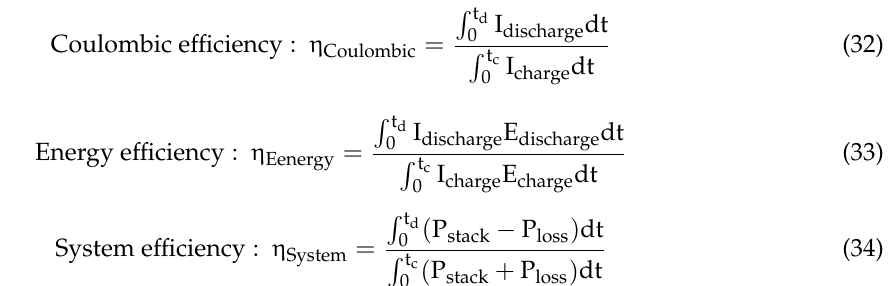
Figure 14. ( a ) System power consumption under different flow control strategies during charging process; ( b ) system output power under different flow control strategies during discharge process.